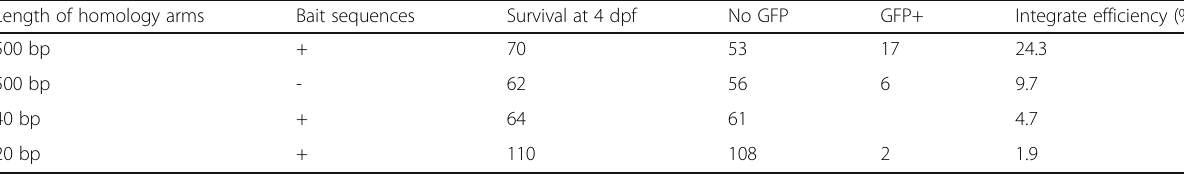
Integrate efficiency (%) = GFP+ / Survival at 4